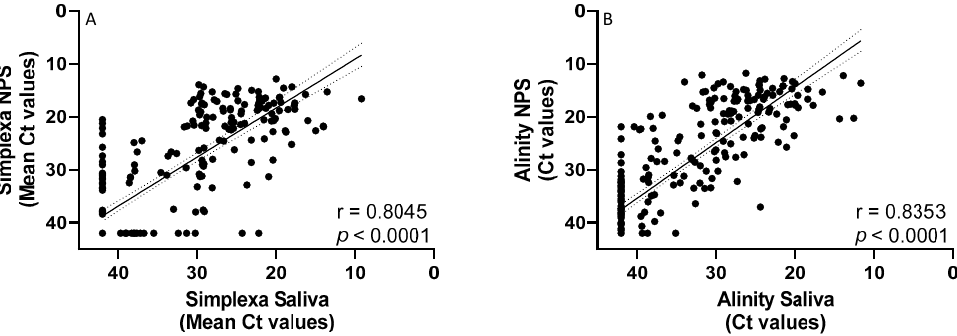
Figure 1. Correlation between Ct values obtained in NPS vs. Ct values obtained in saliva samples using Simplexa and Alinity platform. ( A ) Correlation between Ct values obtained in NPS vs. Ct values obtained in saliva samples using Simplexa; ( B ) Correlation between Ct values obtained in NPS vs. Ct values obtained in saliva samples using Alinity platform. Linear regression with 95% of Confidence Interval (dashed line). For statistical calculations, an arbitrary value of 42 Ct was assigned to negative samples for both assays; results obtained by Simplexa are expressed as the mean of Ct obtained from single genes ORF1ab and S.